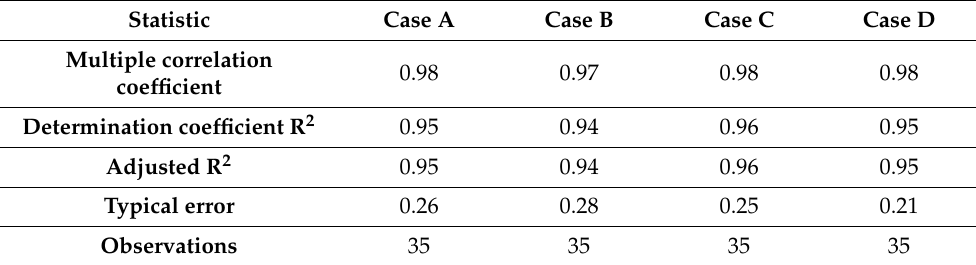
Table 5. Multiple linear regression